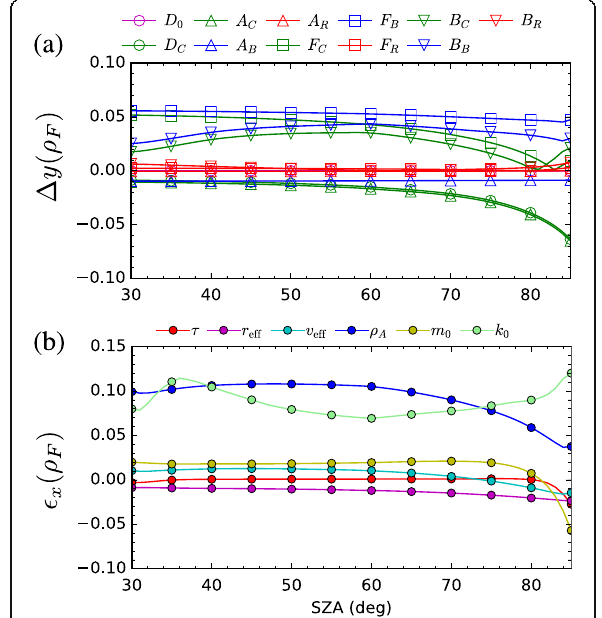
Fig. 11 a Sensitivity of dust observation parameters to the volume mixing ratio of fine mode dust ( ρ F ). Parameter Δ y represents the difference between the maximum and minimum values of the normalized observational parameters when ρ N is changed from 0 to 0.01. b Systematic error due to ignorance of bimodal size distribution. The systematic errors of the normalized dust model parameters are estimated from the differences between the observational parameters calculated with true (0.01) and wrong (0) values of the fine mode dust volume mixing ratio ( ρ F